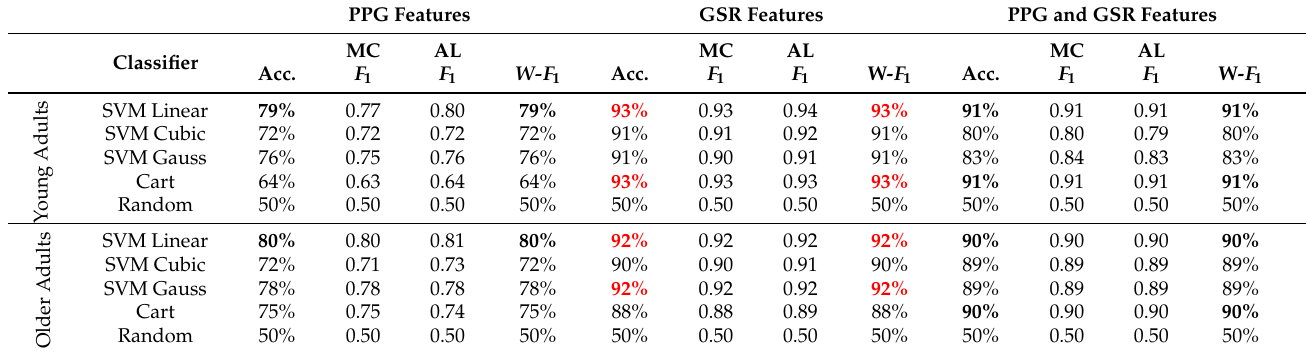
Table 4. Performance of the binary classifiers in discriminating the instances collected during the math calculation tasks MC from the instances collected during the audio listening task AL, varying the feature set and adopting a LOSO validation strategy. Three performance metrics are reported: accuracy (Acc.), F1-score ( F 1 ) and weighted F1-score (W- F 1 ). In each population group, the W- F 1 values in bold represent the best performances achieved for each feature set considered, while in red is highlighted the best accuracy at